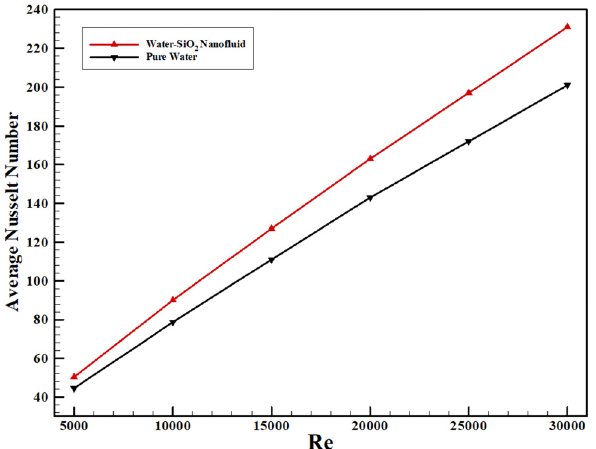
Figure 4: The average Nusselt number versus Reynolds number for various volume fractions, ϕ of water/SiO 2 with dp = 20 nm.